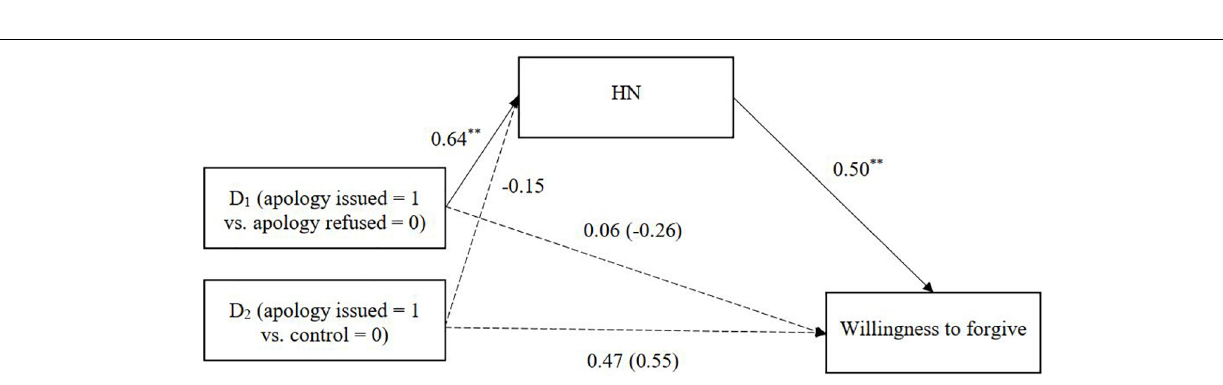
FIGURE 2 | HN mediating the relationship between condition and willingness to forgive (Study 1). Unstandardized coefficients are presented. Coefficients in parentheses denote direct effects after controlling for indirect effects. ∗∗ p < 0.01.